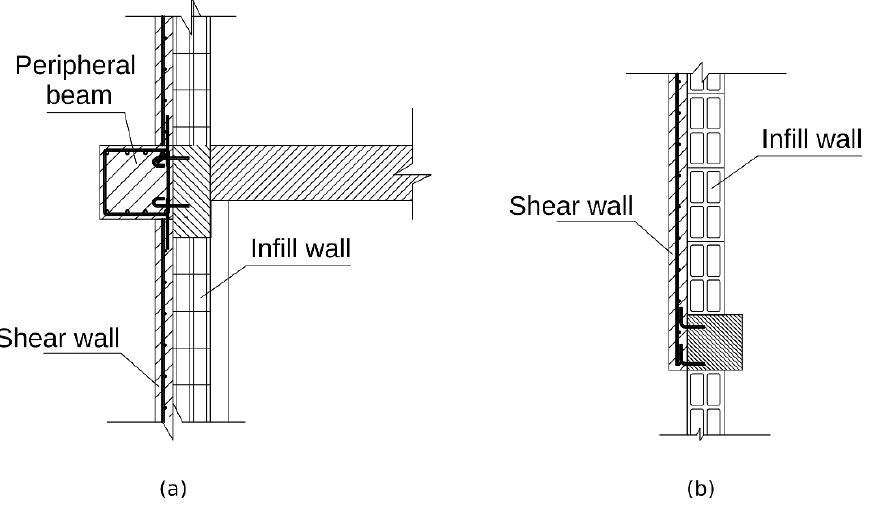
Figure 3. Concrete wall strengthening (Cases 1 and 2); vertical section of typical shear wall and peripheral beams ( a ); and horizontal section of typical shear wall-existing column interface ( b ).